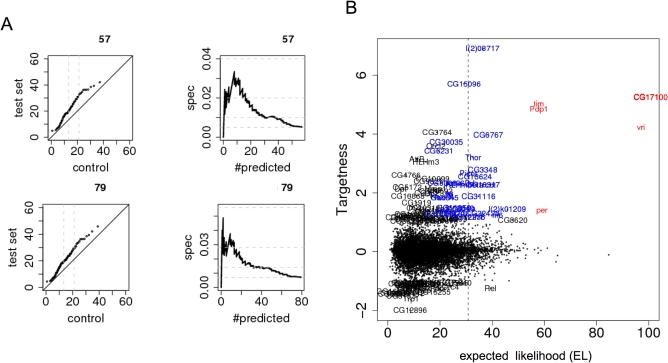
Promoters of Highly Induced Genes in the GR-CLOCK Are Enriched with High Scoring Hits from the E1-E2 Model(A) Left two diagrams: quantile–quantile plots show that expected likelihood (EL) scores of highly induced genes (positives) are shifted upward with respect to the control (negatives). Positives correspond to the 57 (top 0.5%; upper left diagram) or 79 (top 0.7%; lower left diagram) induced genes (ranked according to fold induction; see Methods), while the negative set consists of all remaining genes. Right two diagrams: Specificity versus number of predicted genes (sensitivity) in the group of 57 (upper right diagram) or 79 (lower right diagram). The horizontal lines represent expected specificity (lowest line), 2-fold, 4-fold, and 8-fold enrichment. Importantly, the five training genes are excluded from the set of positives in all panels. The increased specificities are highly significant: in the top row, p = 1.4 × 10−7 for 10 predicted positives (chi-squared test), p = 7.5 × 10−6 for 20, and p = 1.3 × 10−3 for 30 predicted positives. The top 30 positives are marked in blue in (B).(B) Scatter plot representing the targetness score (fold induction in log2 units; see Methods) in function of the expected log-likelihood score of the E1-E2 model in windows of ±2,500 bp around the TSSs. Genes in blue are the 30 genes (from the group of 57) with highest match to the sequence model.